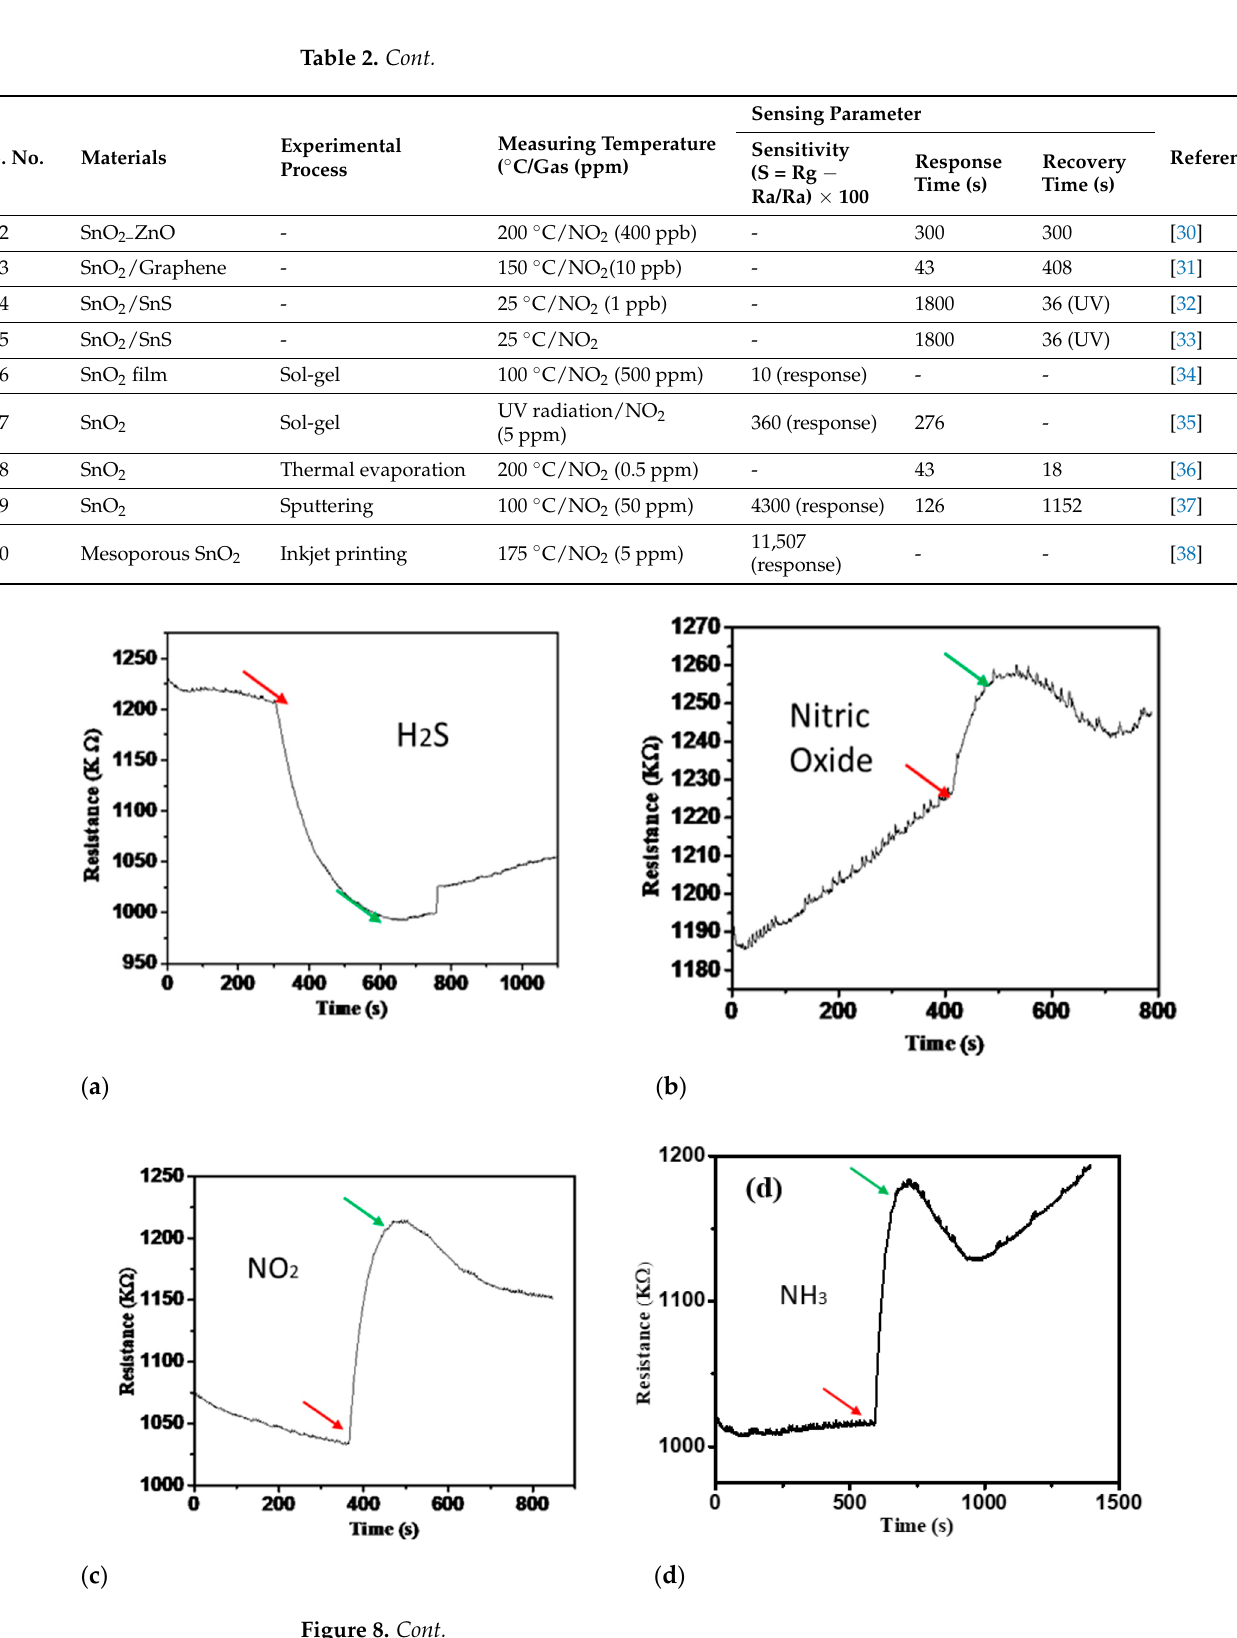
Figure 8. ( a – d ) The sensor performance of 1 ppm of H 2 S, NO, NO 2 , and NH 3 at 150  C. ( e ) ‐ Sensor response for one ppm of NO 2 at 50  C. Table 2. Comparison table for different gases and materials. S.No. Materials Sensing Parameter